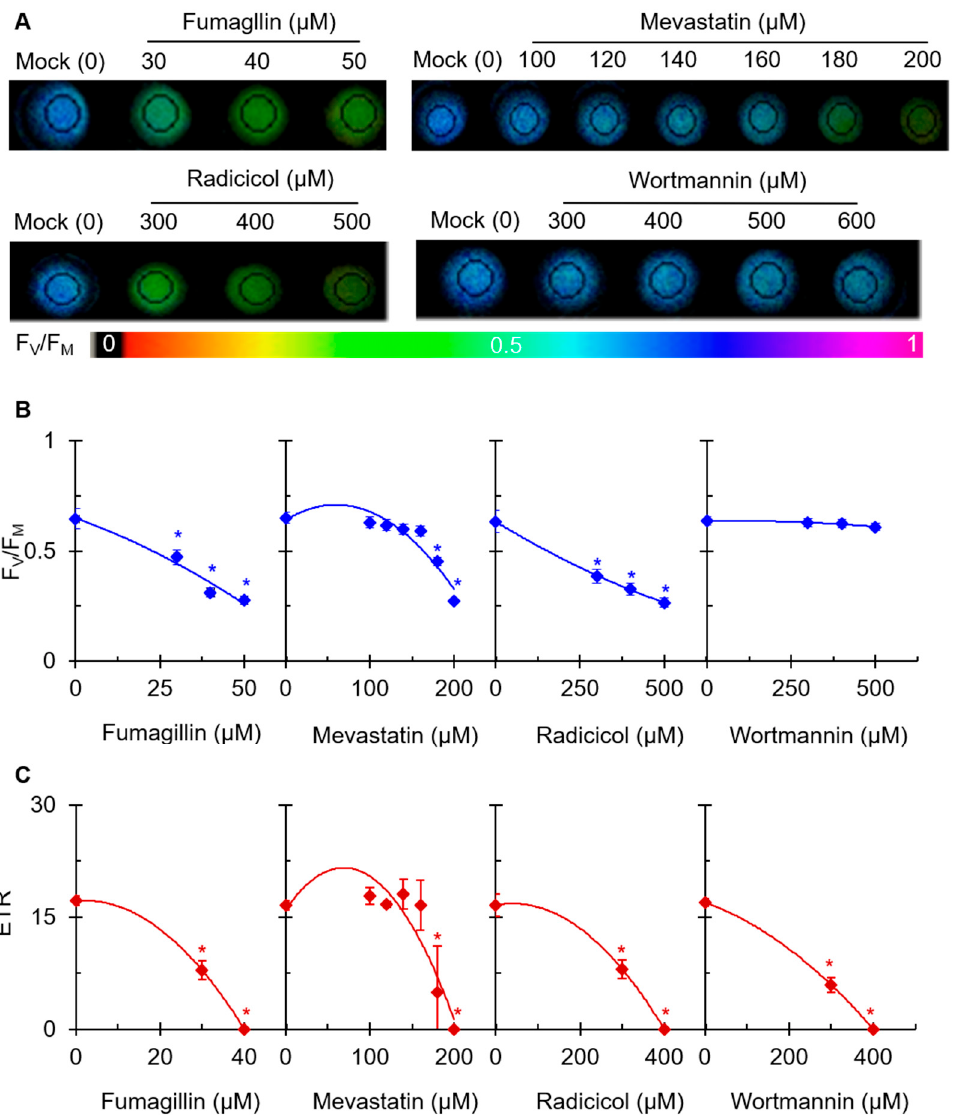
Figure 3. Effects of four mycotoxins on Chl fluorescence of C. reinhardtii cells. Cells were incubated for 3 h with different concentrations of fumagillin (30, 40, and 50 μ M), mevastatin (100, 120, 140, 160, 180, and 200 μ M), radicicol (300, 400, and 500 μ M), and wortmannin (300, 400, 500, and 600 μ M). ( A ) Color fluorescence images of the maximum quantum yield of PSII (F V /F M ). ( B ) F V /F M value. ( C ) The electron transport rate (ETR). Fluorescence images are indicated by the color code in the order of black (0) through red, orange, yellow, green, blue, and violet to purple (1). Each value is the average ± SE of three biological replicates. * indicates significance at p < 0.05.